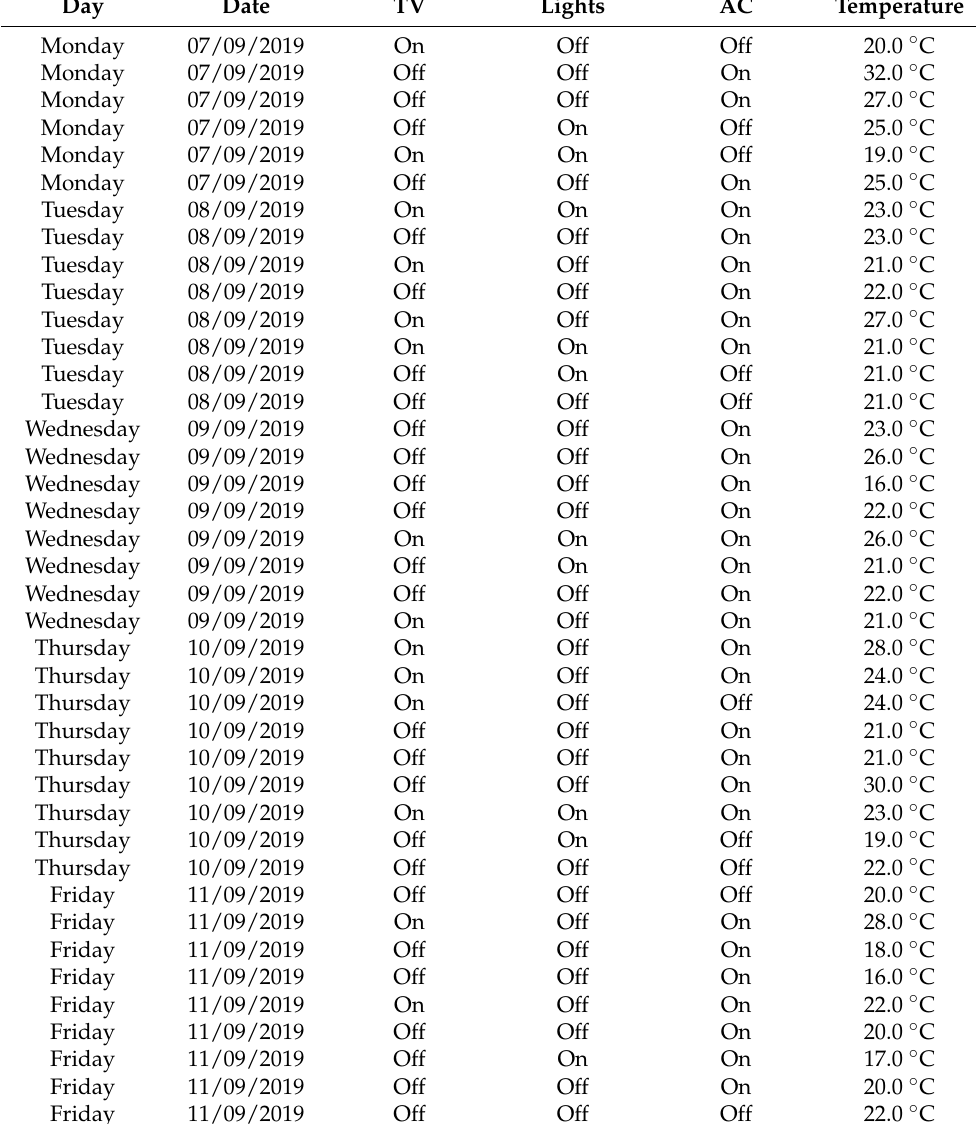
Table 2. Some sensor data collected during the Experimental Case